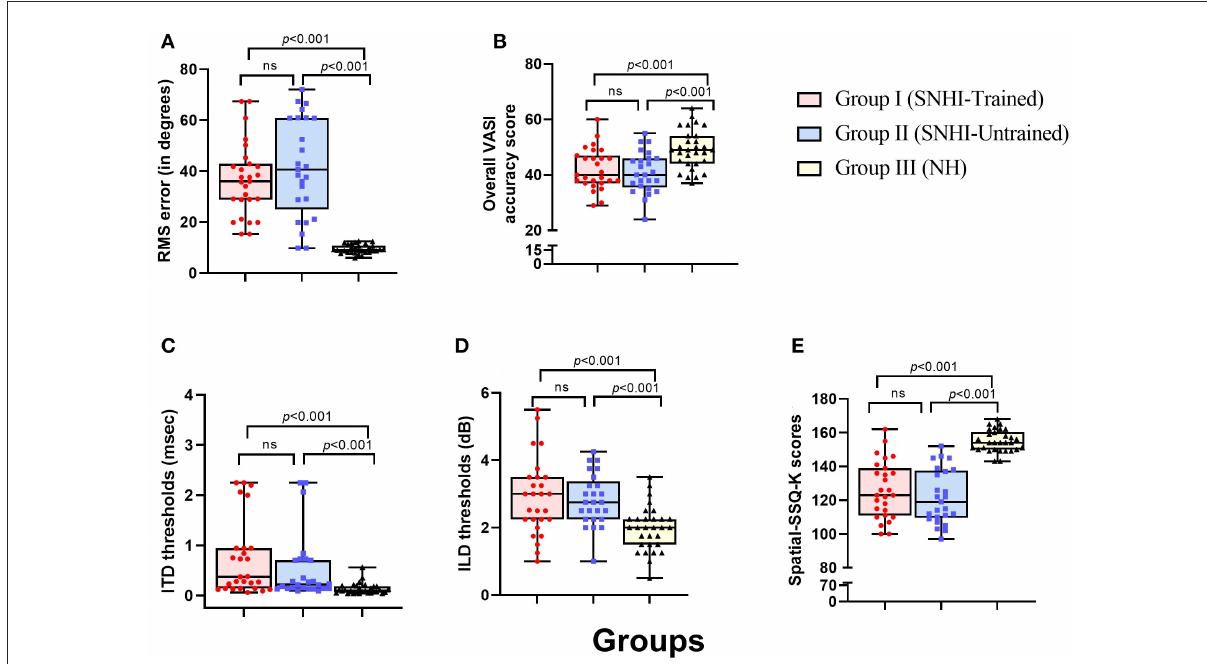
FIGURE4 Comparison of spatial acuity across groups in (A) test of spatial acuity in free field, (B) test of spatial acuity in closed-field, (C) interaural time difference thresholds, (D) interaural level difference thresholds, and (E) subjective ratings on spatial sub-section of SSQ-K. The horizontal line in each box plot at center represents the median, while the “ + ” sign indicates the mean for each test. The box area corresponds to interquartile range, while the error bar indicates interquartile deviation. The results of Bonferonni comparisons are also